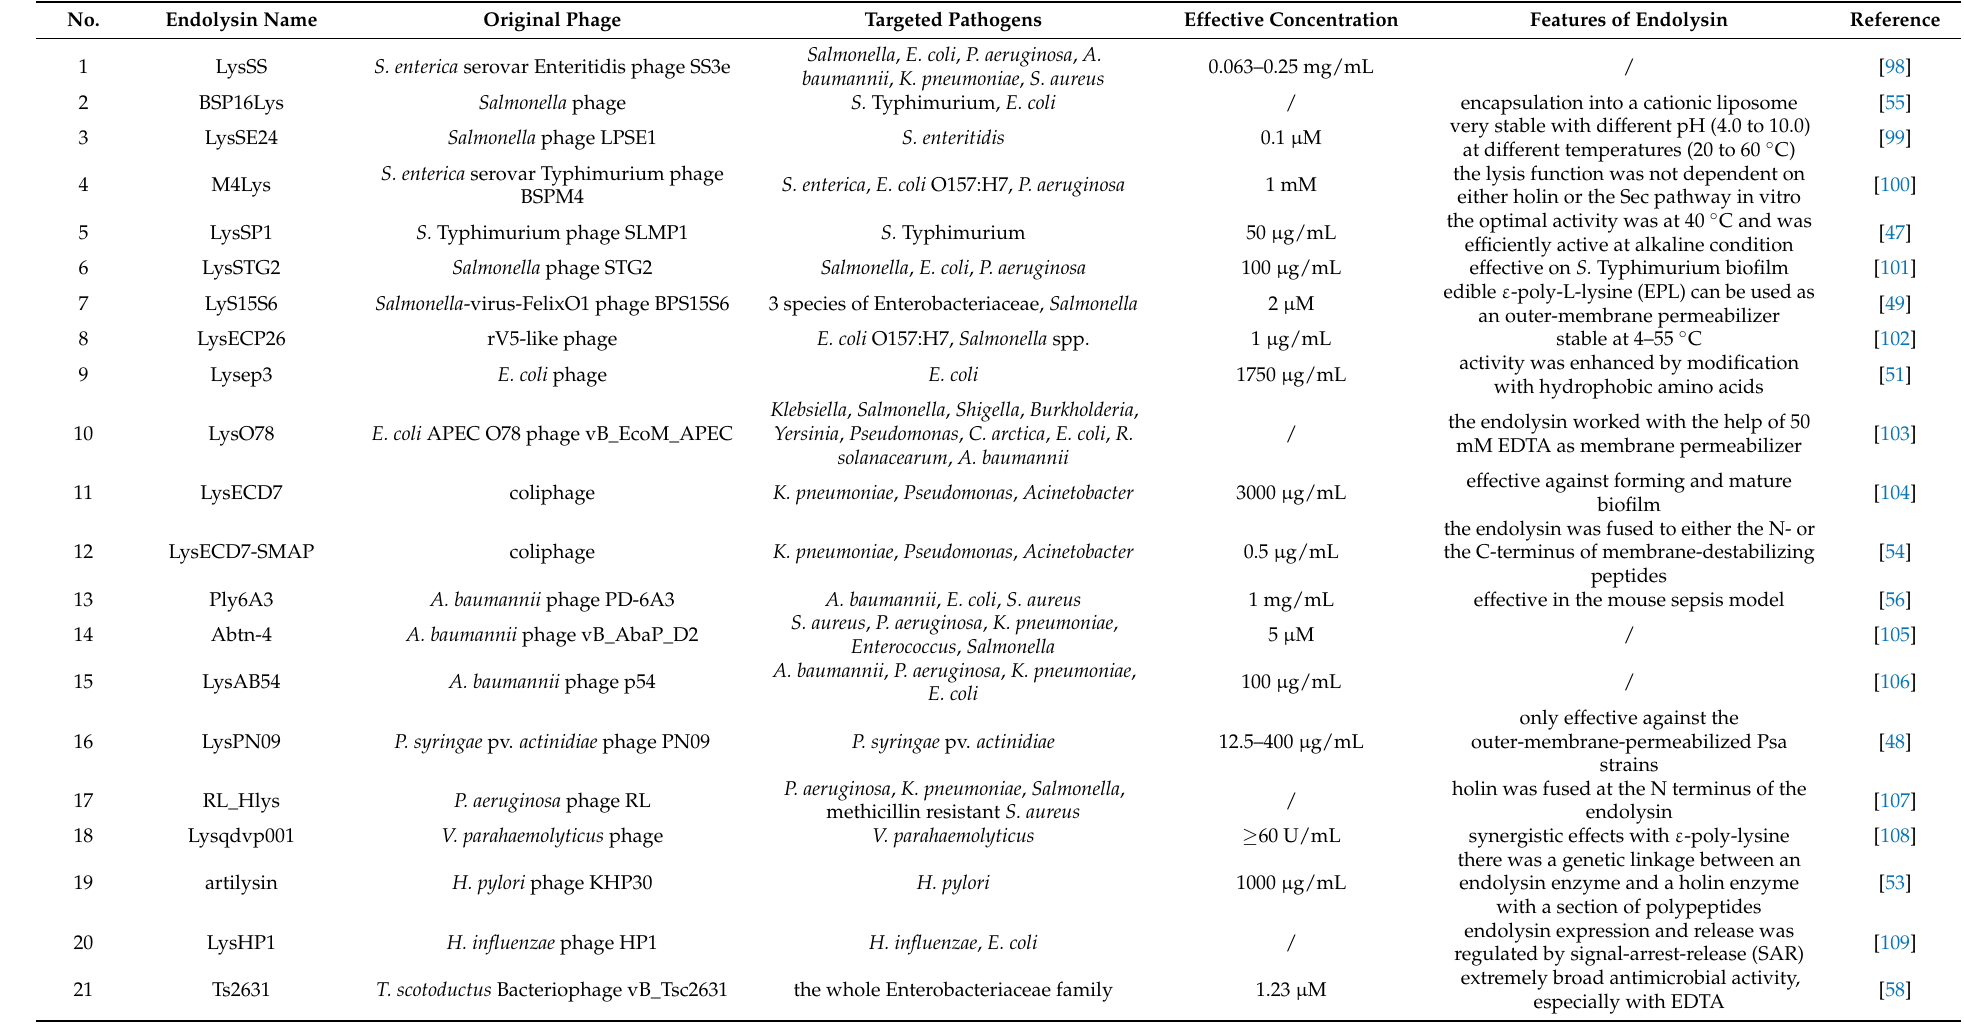
Table 2. Bacteriophage endolysins of Gram-negative bacteria since